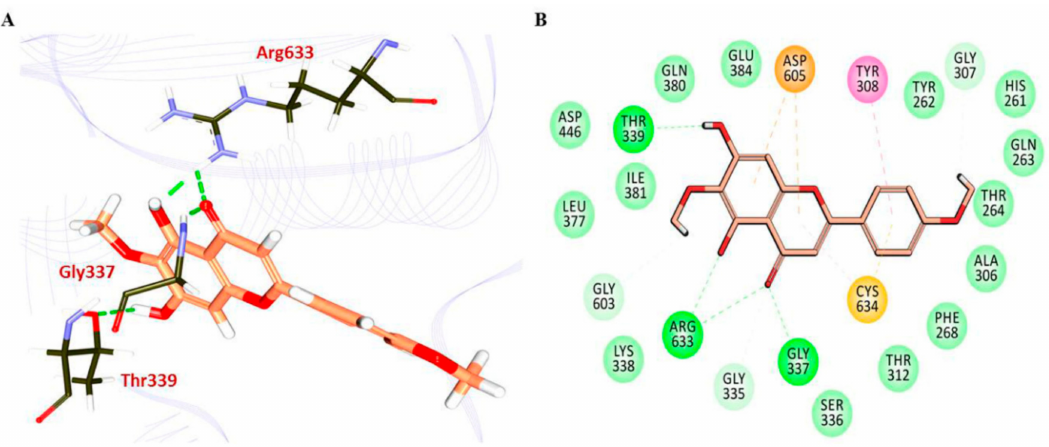
Figure 8. Intermolecular hydrogen bond interactions between protein and the ligands. ( A ) DDX4- Pectolinaringenin complex. ( B ) The residues Gly307, Gly335, Ser336, Lys338, and Gly603 have demonstrated the carbon-hydrogen bonds.